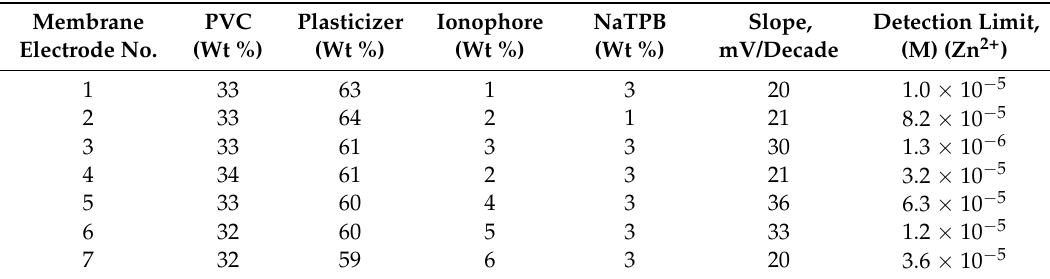
Table 1. Optimization of membrane components for Zn 2+ selective electrode based on diphenylamine derivative. Membrane Electrode No.